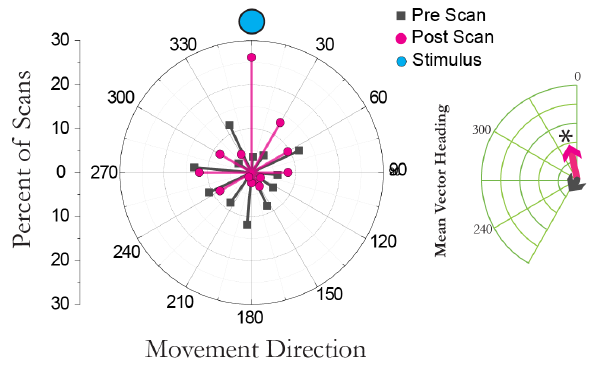
Figure 2. Heading changes after a sequence of scanning behavior. The leech’s heading pre-scan (gray) and post scan (pink) relative to the stimulus (blue-filled circle). These data represent 99 scans from 18 animals. Gray and pink arrows represent the mean vector for the start and end of scanning bouts respectively. * indicates p , 0.001 based on a Raleigh test. Figure 3. Scanning behavior occurs with the same frequency